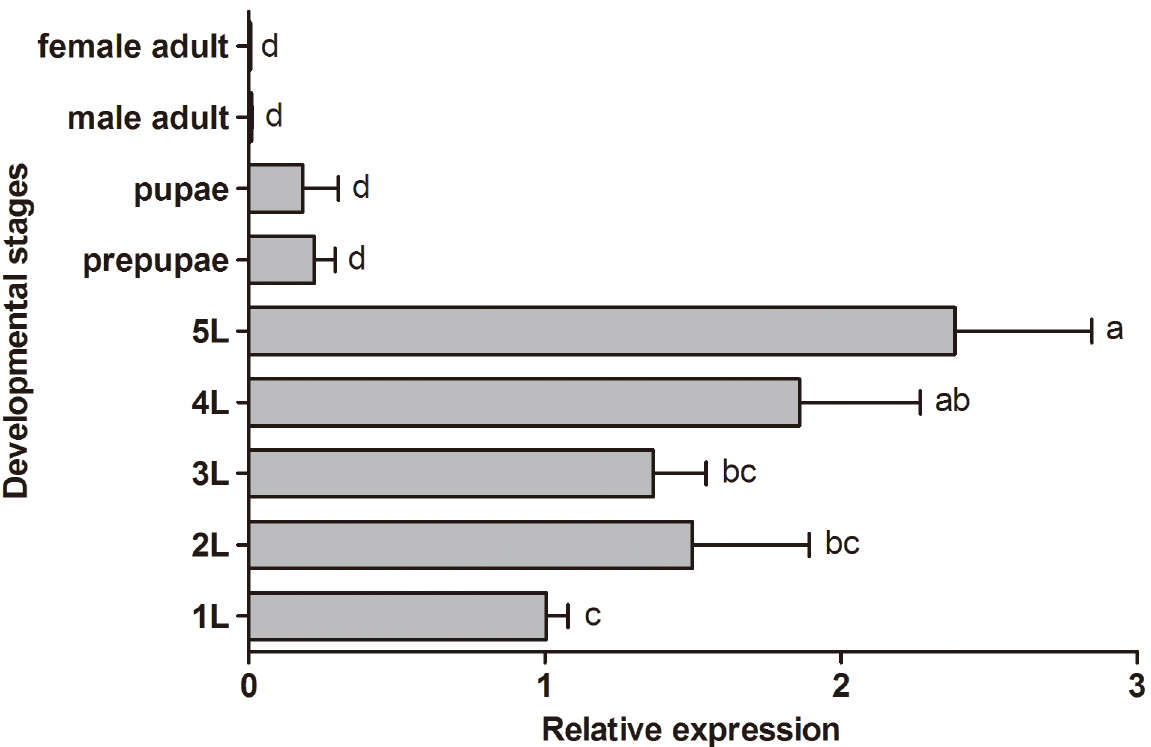
Fig 4. Expression pattern of a fibroin light chain gene at the indicated CLR developmental stages. Insect life stages are indicated on the vertical axis and relative gene expression (as fold-change) on the horizontal axis. Histogram bars annotated with the same letter are not significantly different.